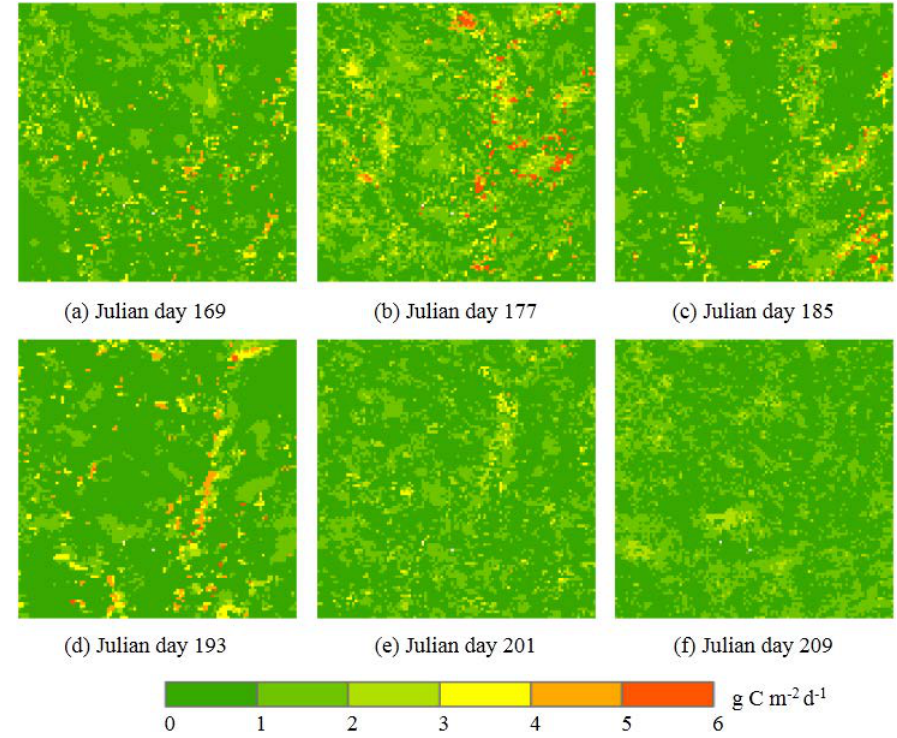
Figure 6. The spatial distribution of absolute GPP differences between the 500 m MODIS GPP and the downscaled GPP results for Julian days 169–209. Figures ( a – f ) indicate Julian days 169–209, respectively.